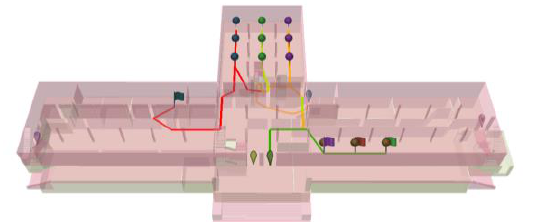
Figure 18. Generated Staff Evacuation Ground Floor Routes